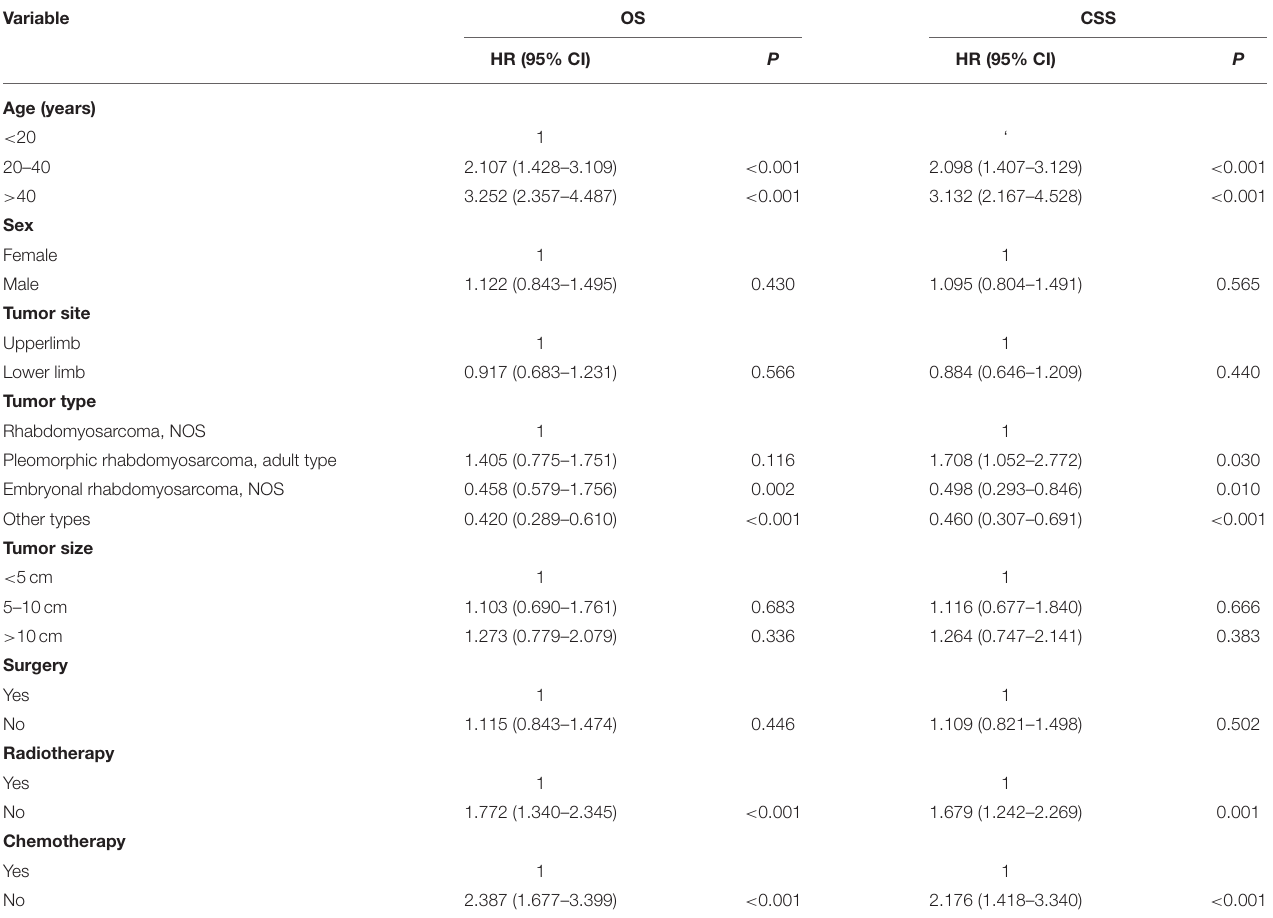
TABLE 2 | Univariate Cox analysis of variables in patients with limb rhabdomyosarcoma and metastasis at diagnosis.